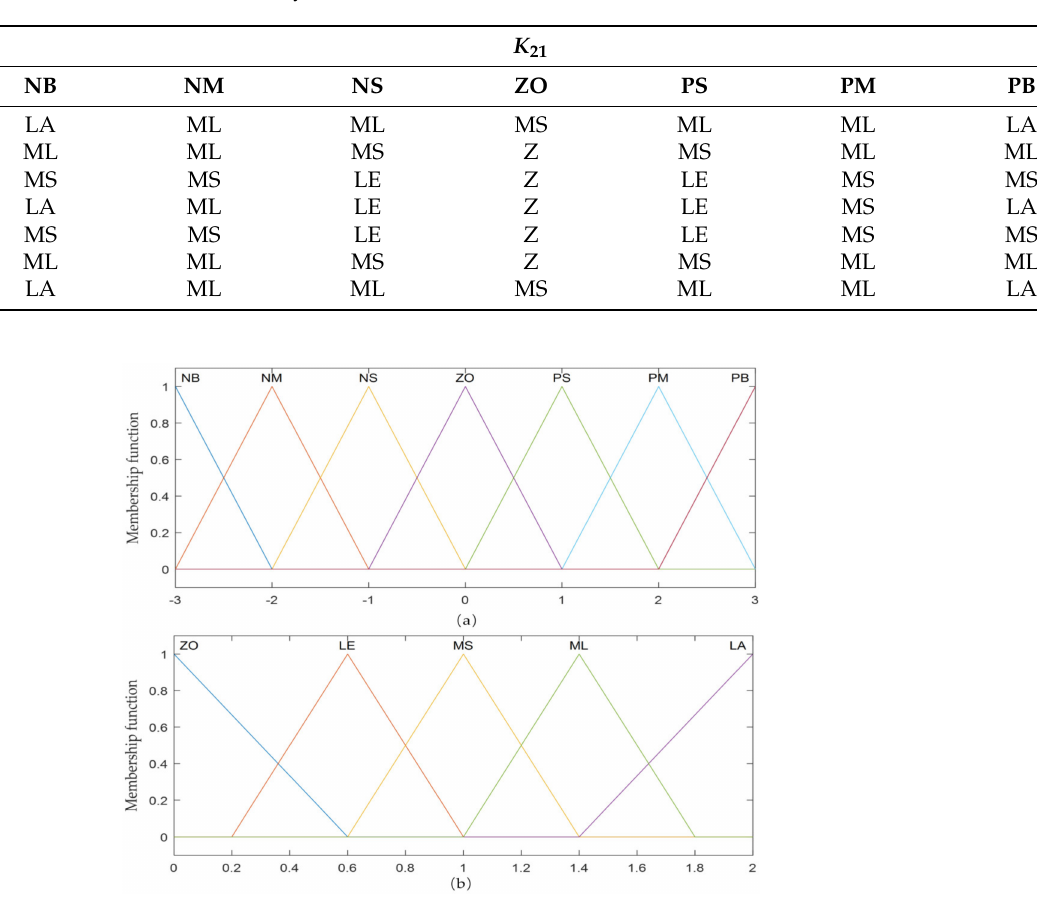
Figure 3. Membership functions: ( a ) s and